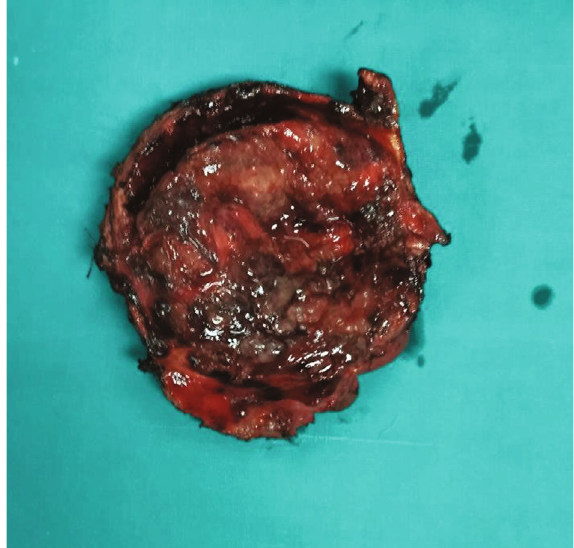
Figure 4: Specimen of completely excised choledochal cyst.